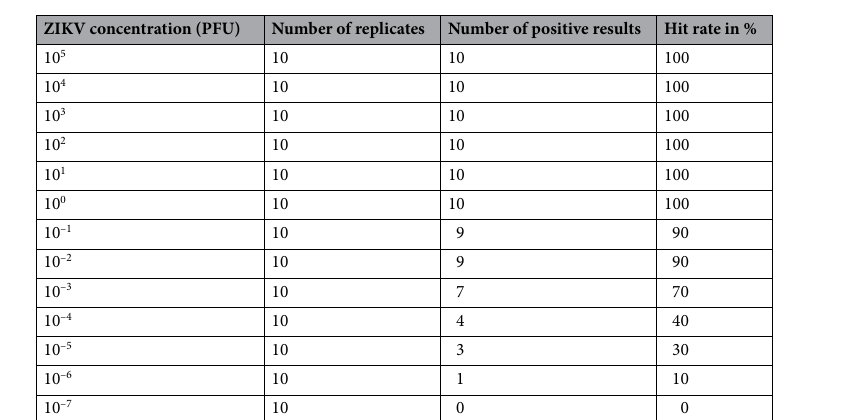
Table 2. Limit of detection (LOD) of the RT-LAMP assay for ZIKV detection.